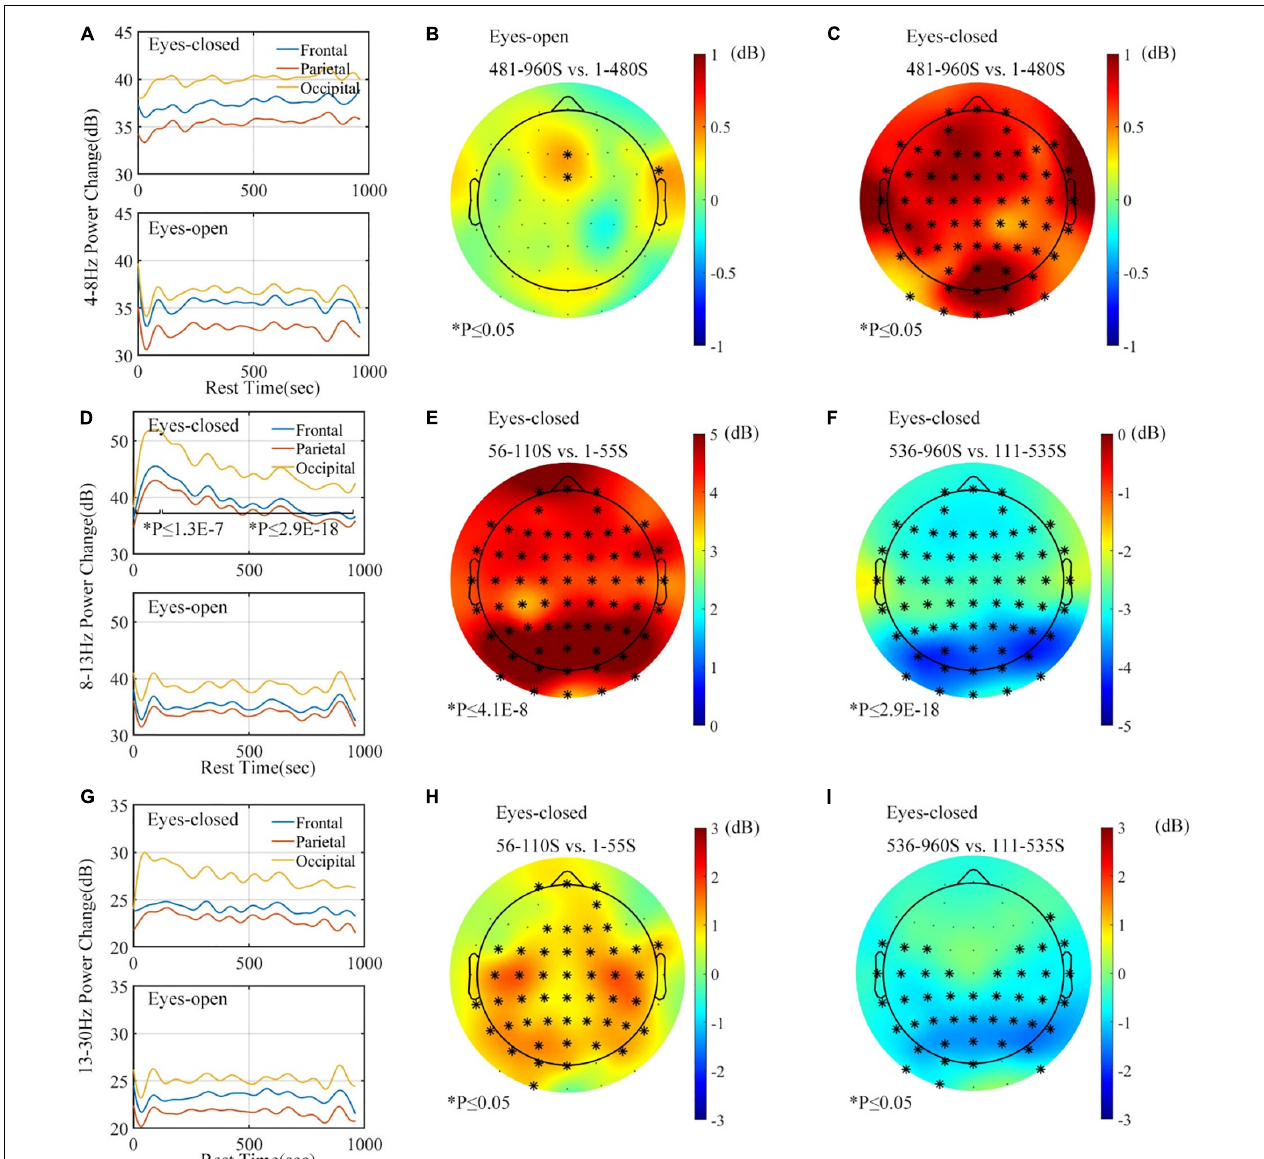
FIGURE 12 | Band power analysis for rest task (frontal: FPx AFx Fx; parietal: FCx Cx CPx; occipital: Px POx Ox Ix). (A) Theta-band (4–8 Hz) power graph according to brain area. (B) Topographic map of theta (4–8 Hz) variation during eyes-open rest. (C) Topographic of theta (4–8 Hz) variation during eyes-closed rest. (D) Alpha-band (8–13 Hz) power graph according to brain area. (E) Topographic of alpha (8–13 Hz) variation during the first 110 s of eyes-closed rest. (F) Topographic of alpha (8–13 Hz) variation during the next 850 s of eyes-closed rest. (G) Beta-band (14–24 Hz) power graph according to brain area. (H) Topographic map of beta (14–24 Hz) variation during the first 110 s of eyes-closed rest. (I) Topographic map of beta (14–24 Hz) variation during the next 850 s of eyes-closed rest. ∗ p ≤